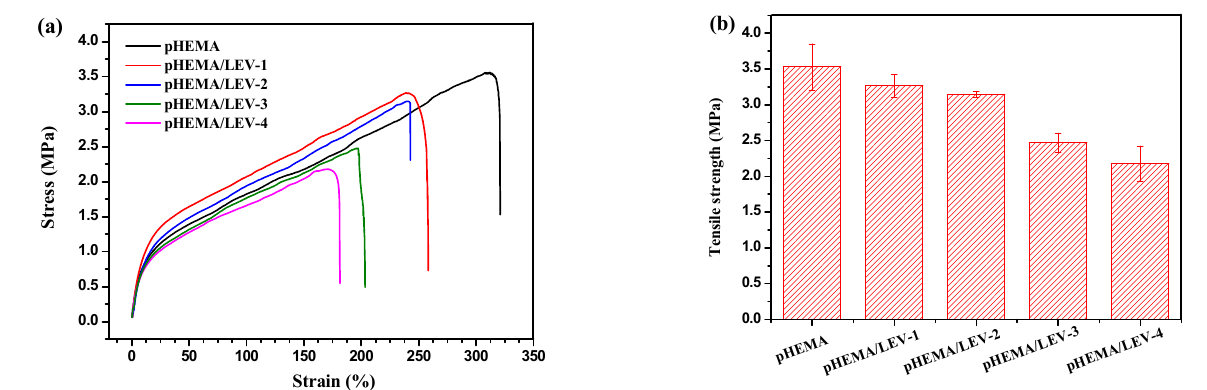
Figure 8. Tensile stress-strain curves ( a ) and tensile strength at break ( b ) of pHEMA hydrogels with different nanogels content.